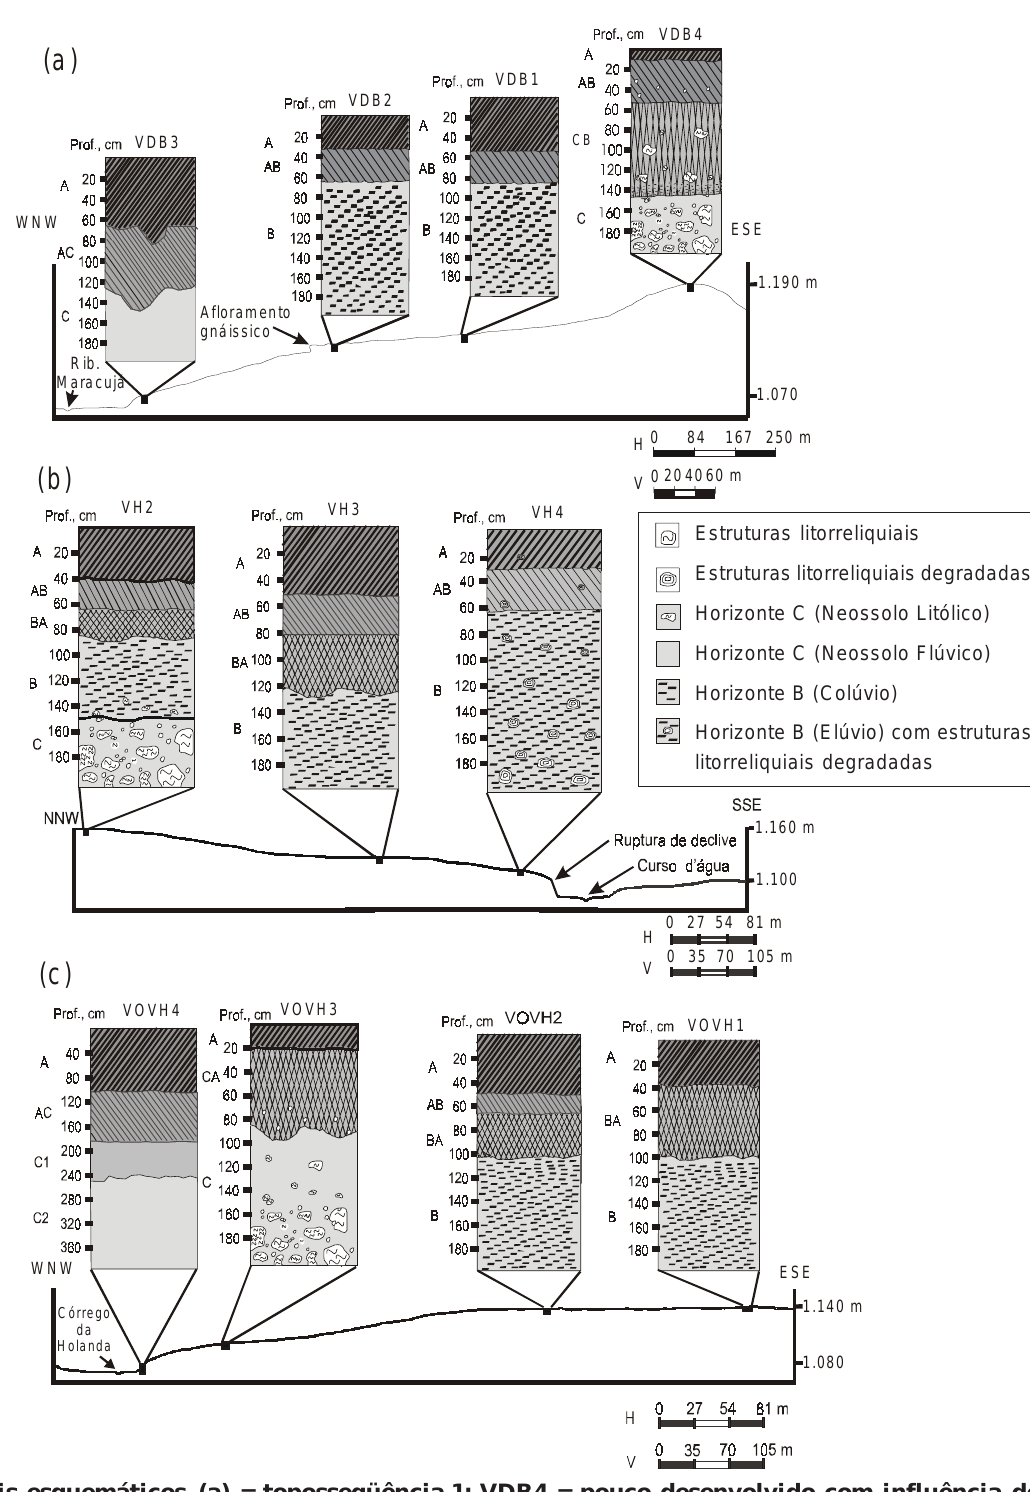
Figura 3. Perfis esquemáticos. (a) = toposseqüência 1; VDB4 = pouco desenvolvido com influência do material parental em todos os horizontes; VDB1 e VDB2 = Latossolos, cujo materiais constituintes são de natureza alóctone; VDB3 = pouco desenvolvido, oriundo de ambiente redutor fluvial sobre horizonte C parental gnáissico. (b) = toposseqüência 2; VH2 = Cambissolo de natureza autóctone; VH3 = Latossolo de natureza alóctone; VH4 = Latossolo Câmbico de natureza autóctone. (c) = toposseqüência 3; VOVH1 e VOVH2 = Latossolos com manchas lito e pedorreliquiais; VOVH3 = solo pouco desenvolvido inteiramente sob influência do material parental gnáissico; VOVH3 = Neossolo Flúvico com horizonte C bastante